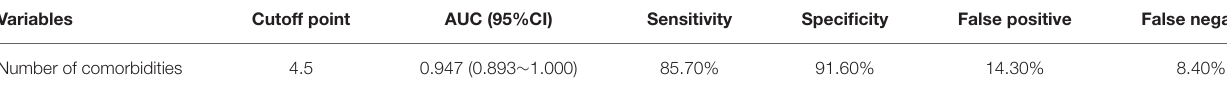
TABLE 9 | The performance of various methods for distinguishing between the dead cases and the survived patients( n = 718).